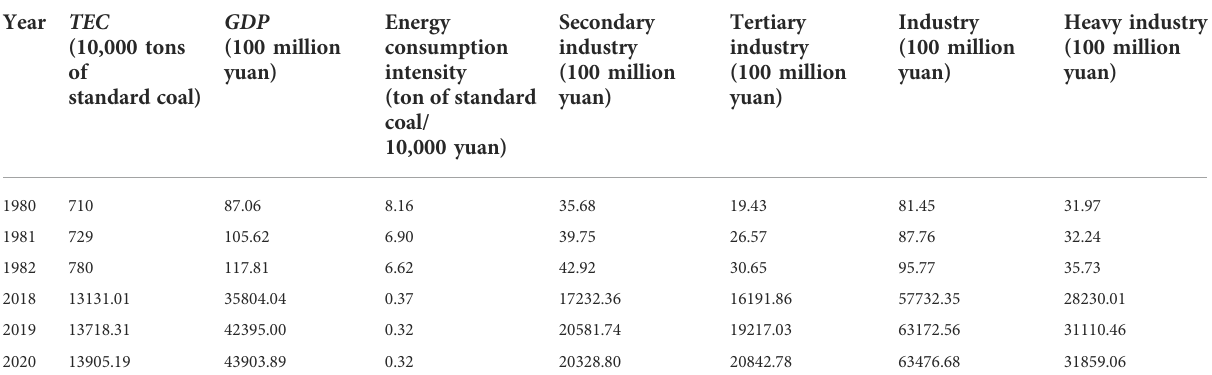
TABLE 1 Basic data of statistical yearbook.